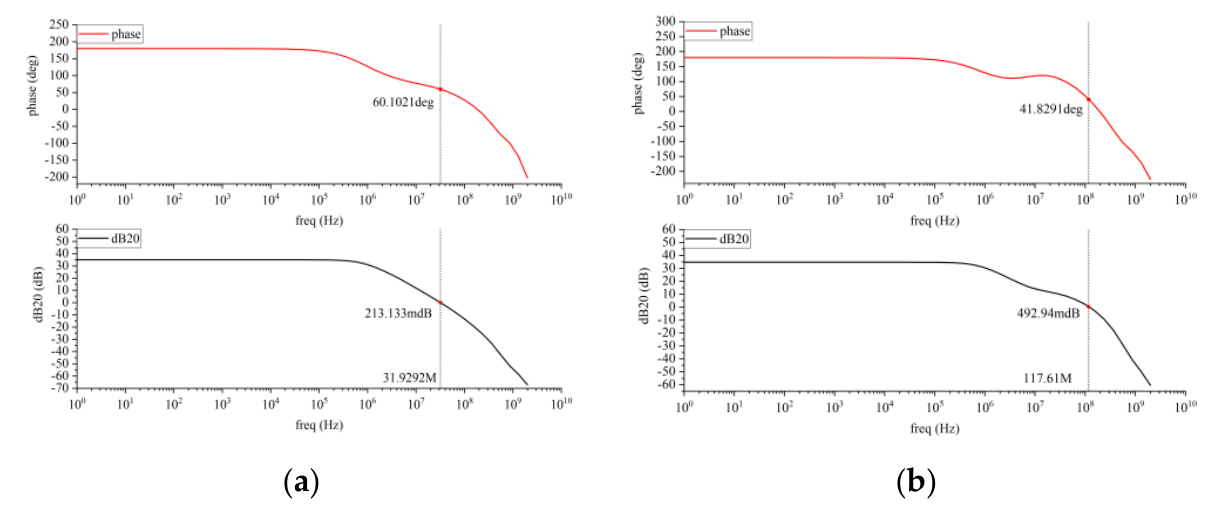
Figure 12. ( a ) Miller compensation, and ( b ) compensation by introducing extra zeros.